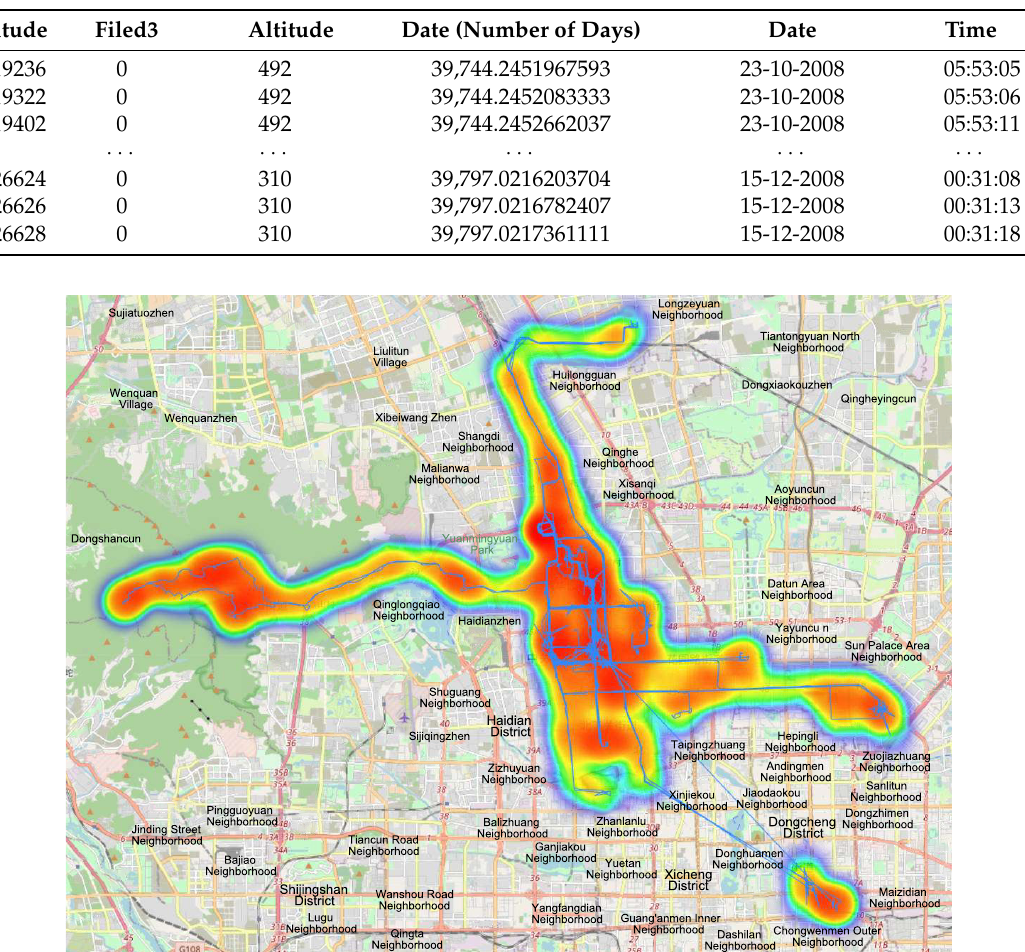
Table 1. Data format of trajectory.